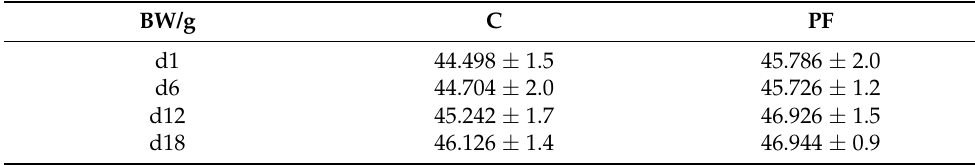
Table 1. Bodyweight changes in mice treated with prodigiosin for 18